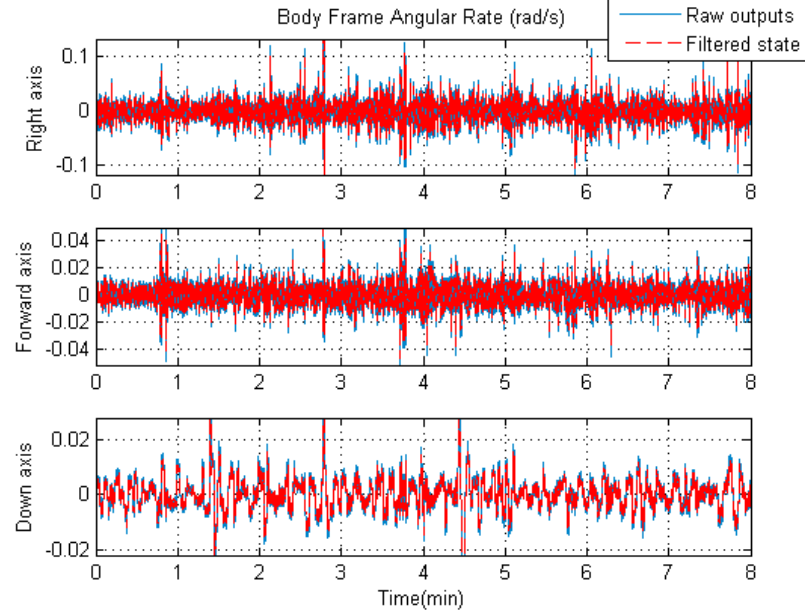
Figure 7. The raw angular rate of the central IMU and the filtered angular rate.